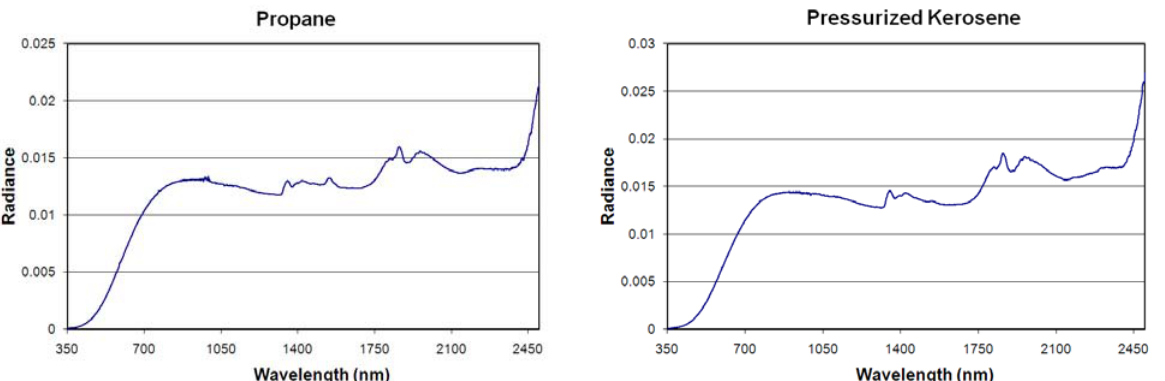
Figure 6. Emission spectra of lanterns burning pressurized